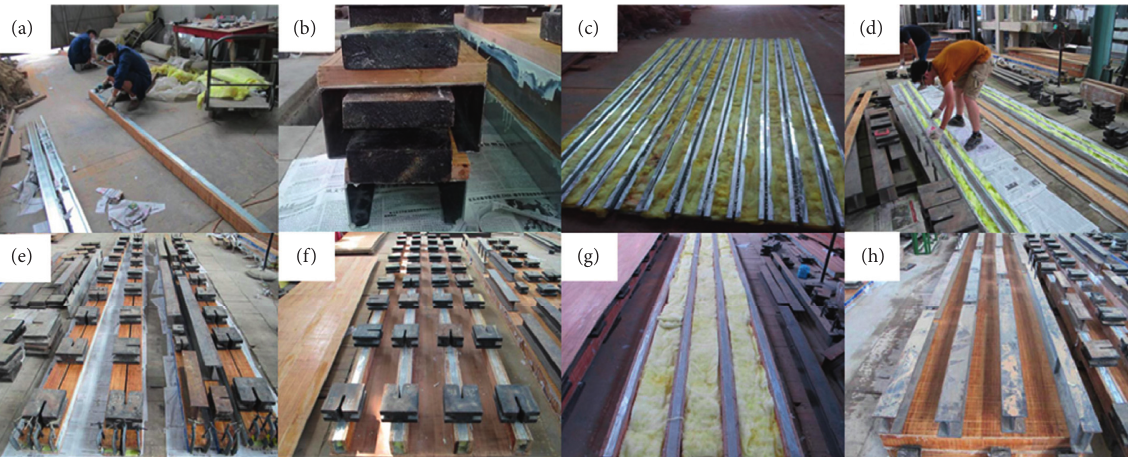
Figure 5: Production processes of composite walls.